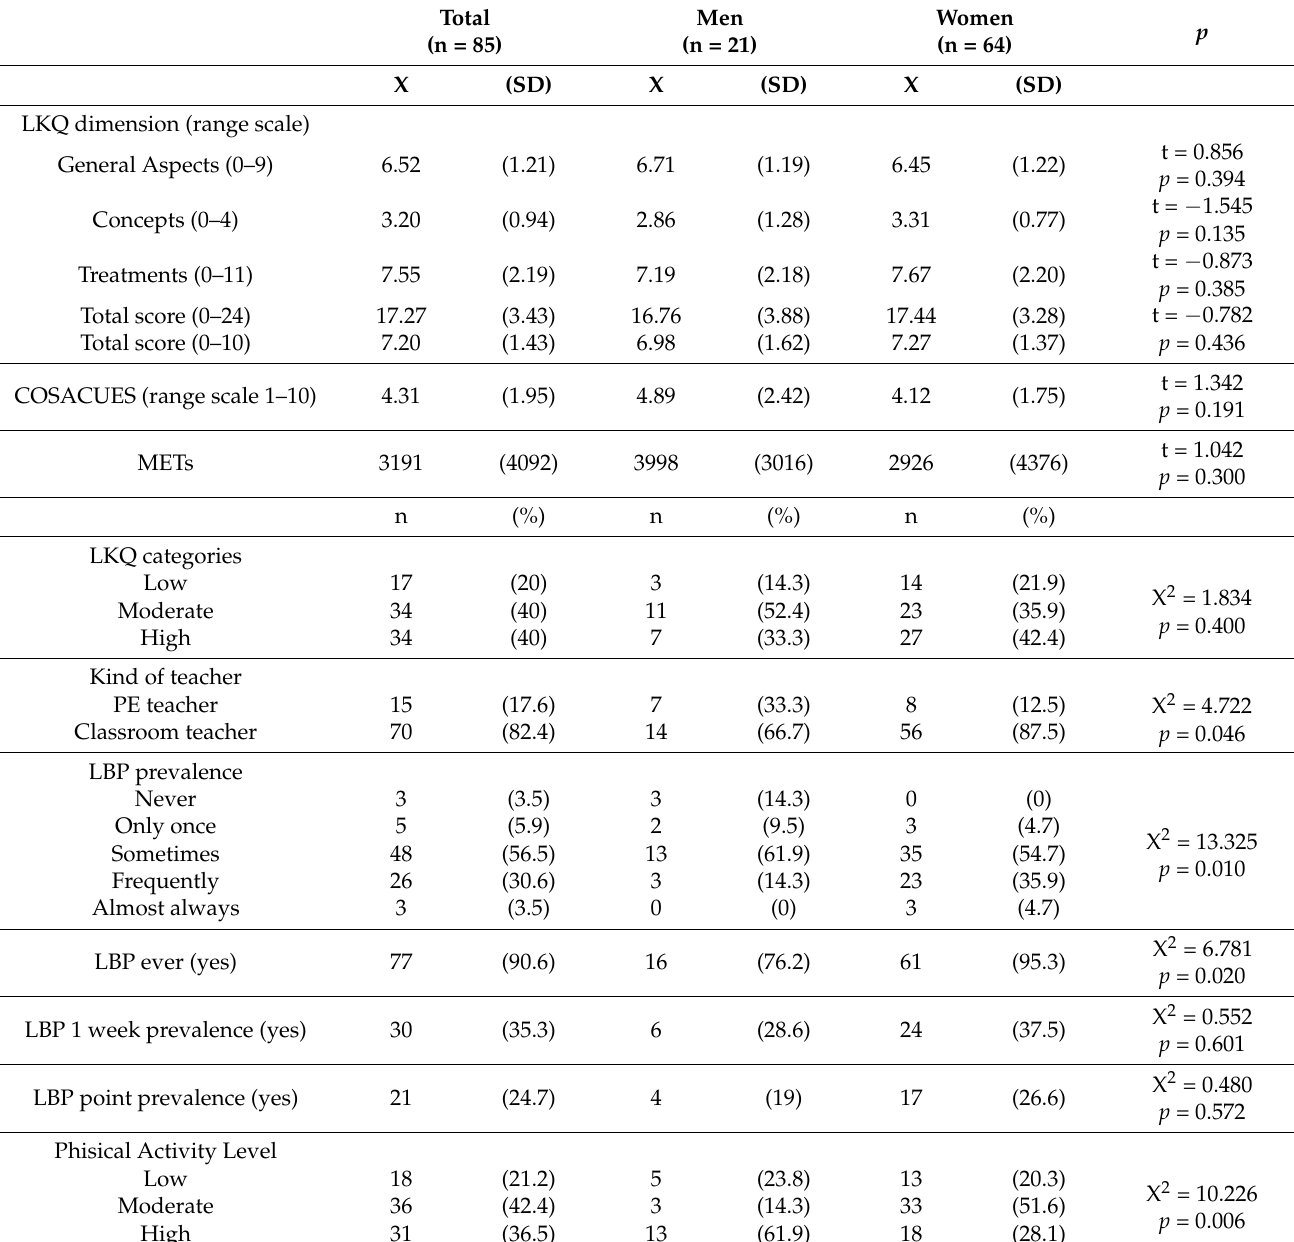
Table 1. Characteristics of the total sample by